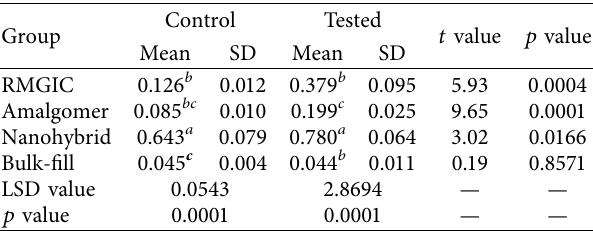
Figure 2: Graphical presentation of ANOVA results of surface microhardness (kg/mm 2 ) of the tested materials. Table 2: Student’s t -test, ANOVA, and post hoc tests of the surface roughness